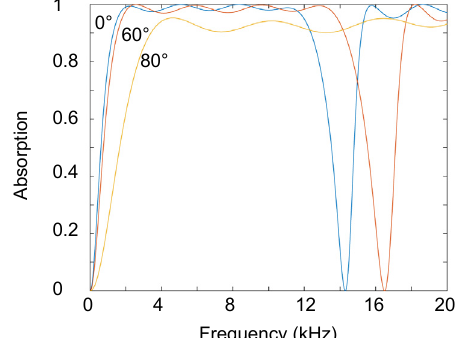
Fig. 5 | Angular dependence of the Jaumann absorber. As the incidence angle is increased from the 0° to 80°, the absorption valley position at about 14 kHz shifts to higher frequencies, accompanying with a small decrease of the absorption efficiency.